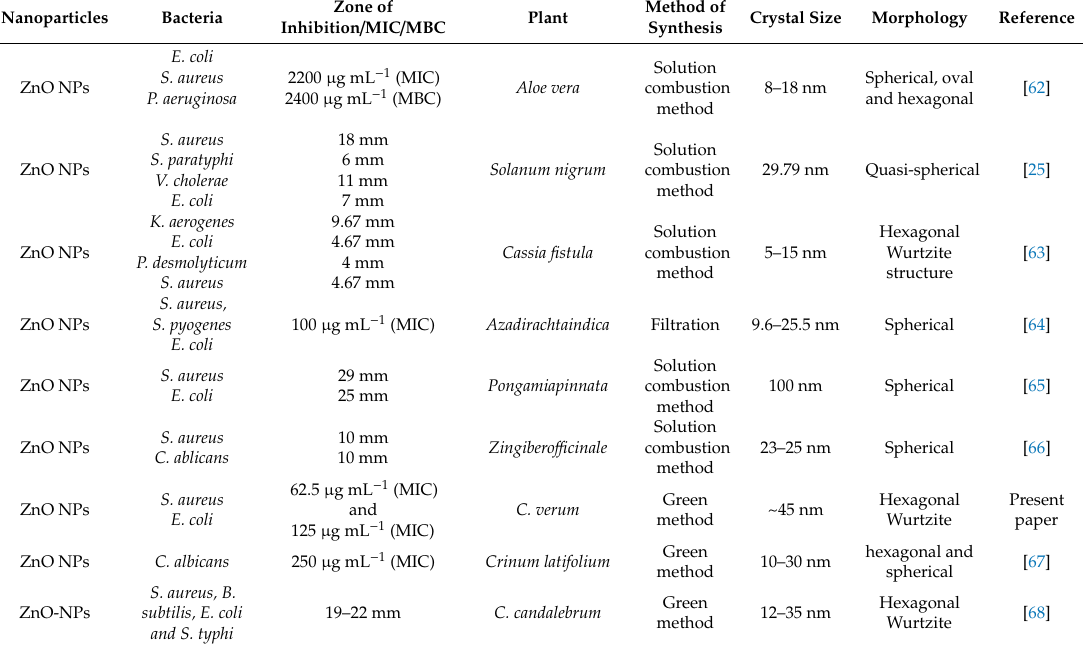
Figure S1. Chromatogram of C. verum bark hexane extract analyzed on GC-MS, Figure S2. Retention time (RT) Library of C. verum bark hexane extract showing the eugenol content, Figure S3. UV- visible spectra of various ZnO-NPs green synthesized using di ff erent concentration of C. verum hexane extract, Figure S4. FT-IR Spectra of C. verum bark hexane extract (A) and its green synthesizesd ZnO-NPs (B), Figure S5. Minimum Inhibitory Concentration (MIC) of green synthesized ZnO-NPs from C. verum bark. hexane extract. A- E. coli ; B- S. aureus